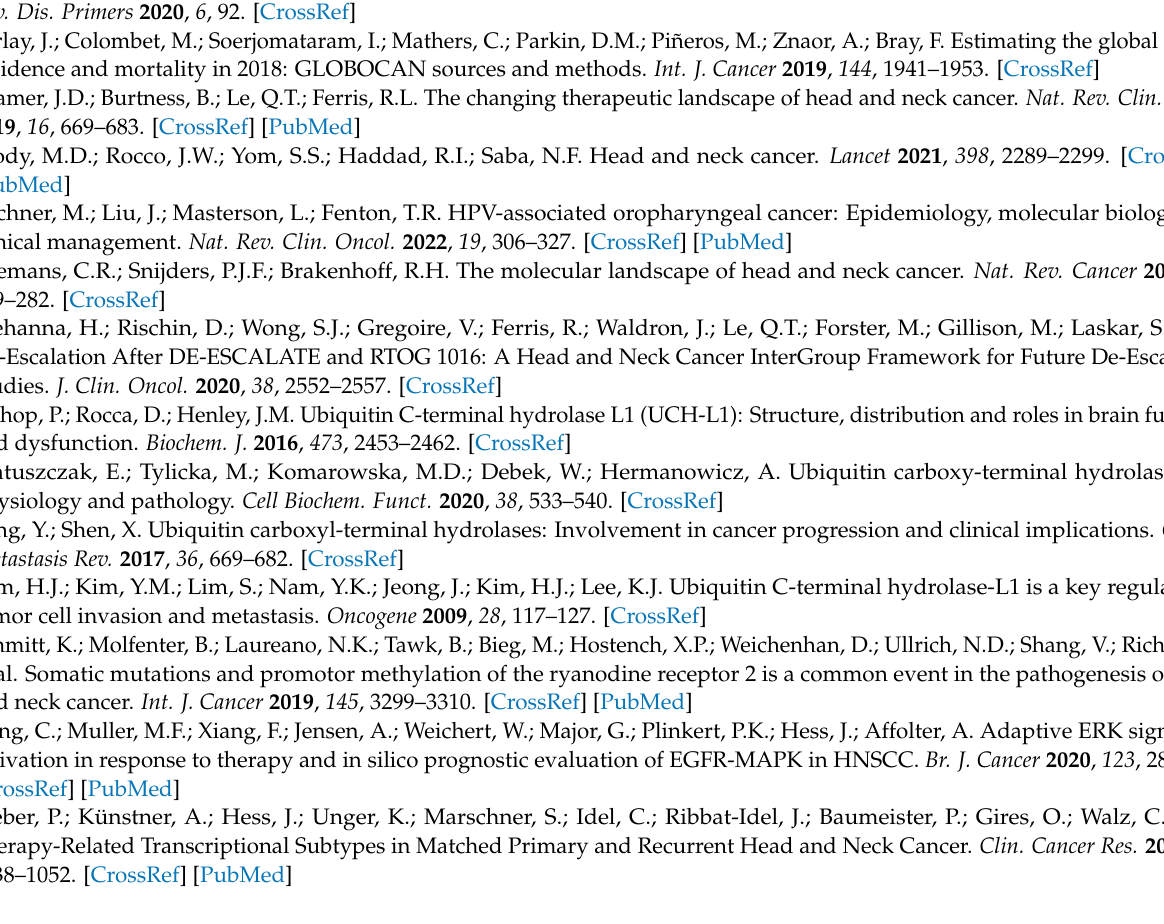
tumors; Supplementary Figure S3: Evaluation of the ML model for TCGA-HNSC; Supplementary Figure S4: UCHL1 protein expression in selected solid tumors from The Human Protein Atlas; Supplementary Figure S5: Evaluation of the ML model for TCGA PanCancer; Supplementary Figure S6: Evaluation of the ML model for established cancer cell lines from CCLE; Supplementary Figure S7: Enrichment of PI3K-AKT-MTOR signaling in cancer cell lines and tumors from TCGA PanCancer